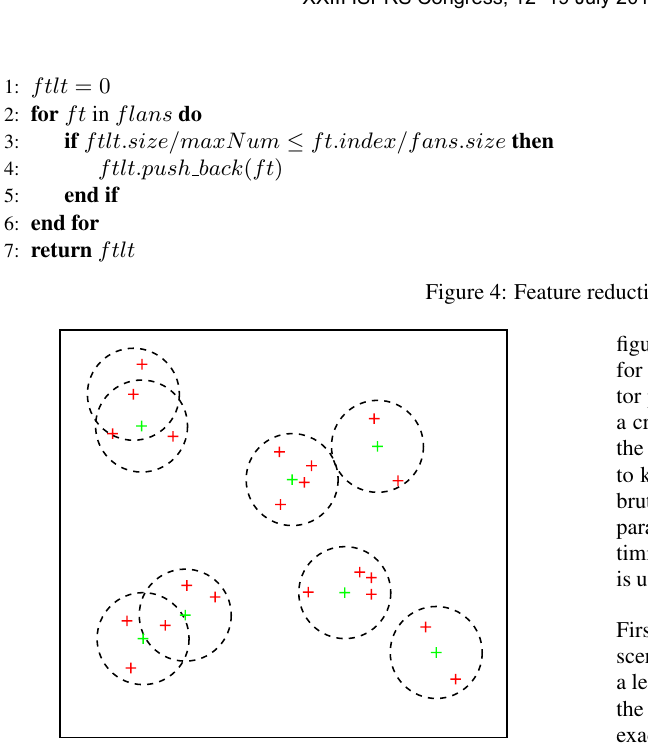
Figure 3: The green crosses are the features being kept; the red are suppressed. The radius of circle is the minimum feature dis- tance, the center point in the top left circle is suppressed, because it has not the highest score in its circle